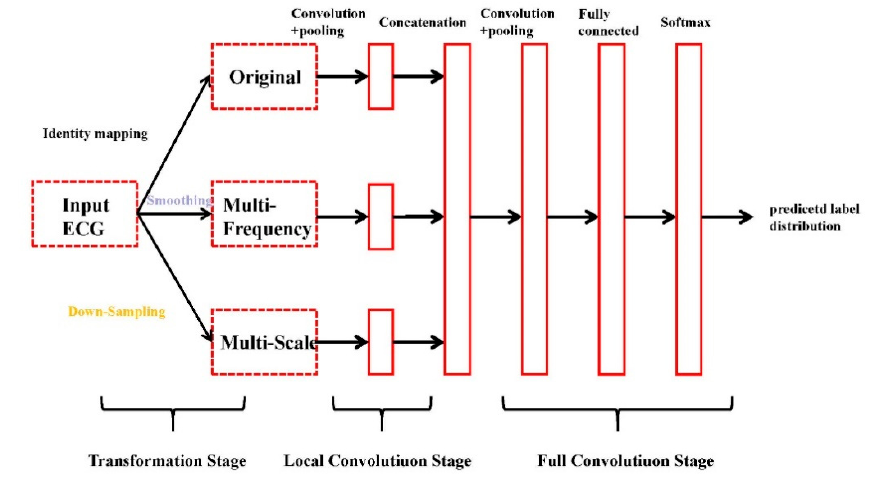
Figure 6. The overall architecture of multi-convolutional neural network (MCNN) [34].